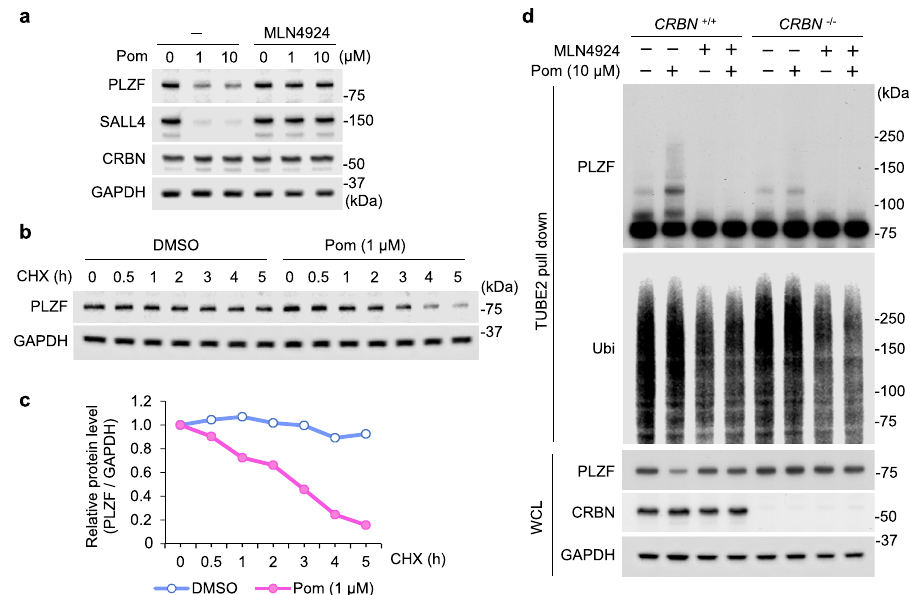
Fig. 2 PLZF is a pomalidomide-speci fi c neosubstrate of CRL4 CRBN . a Lt-NES cells were incubated with DMSO or pomalidomide at the indicated concentration for 6 h and harvested for immunoblot analysis. Cells were pretreated with DMSO or 1 μ M MLN4924. b Immunoblot analysis of lt-NES cells treated with 100 µ g/mL CHX and DMSO or 1 μ M pomalidomide for the indicated periods. c PLZF protein levels in b were quanti fi ed, and relative intensities of PLZF/GAPDH are shown. d Wild-type or CRBN -de fi cient lt-NES cells were treated with 10 µ M pomalidomide and/or 1 µ M MLN4924 for 7 h and subjected to af fi nity puri fi cation of ubiquitinated proteins using TUBE2 agarose beads. WCL whole-cell lysate. All experiments were conducted more than three times with similar